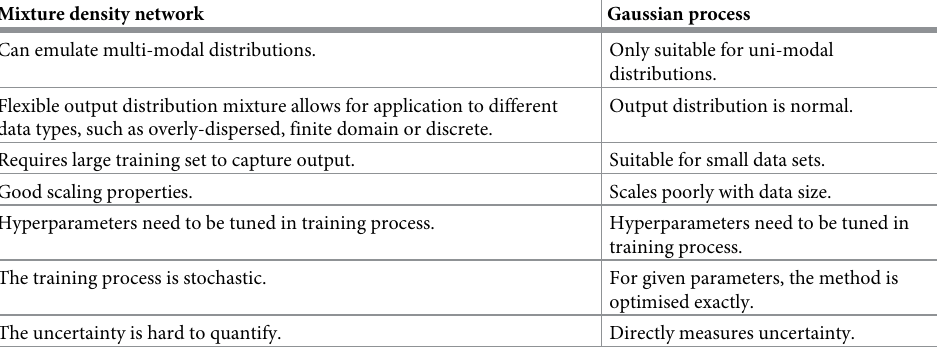
Table 1. A comparison of mixture density networks and Gaussian processes. Mixture density network Gaussian